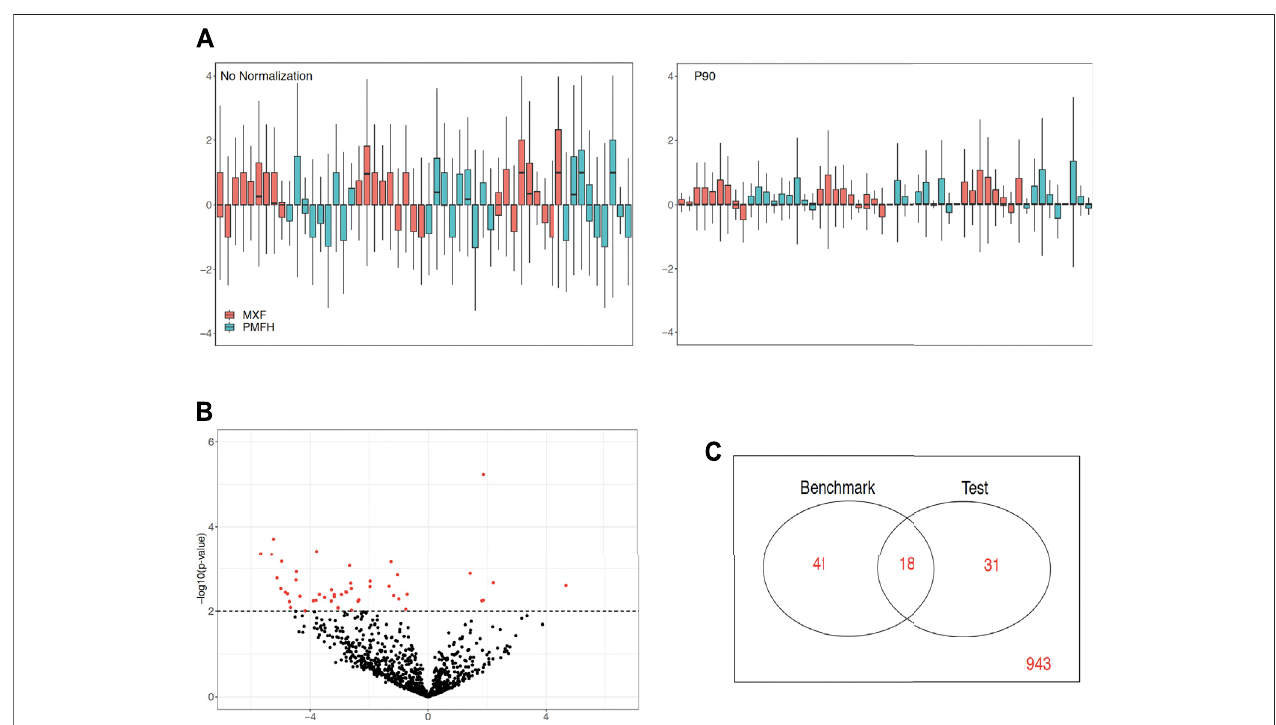
FIGURE2| Graphicaldisplayofmethod-speci fi cempiricalassessmentresultsforP90normalizationusing PRECISION.seq . (A) RLEplotforlog2countdatabefore (left panel) and after P90 (right panel), (B) Volcano plot for p -values versus group mean differences after P90, (C) Venn diagram of DE statuses before versus after P90 normalization.